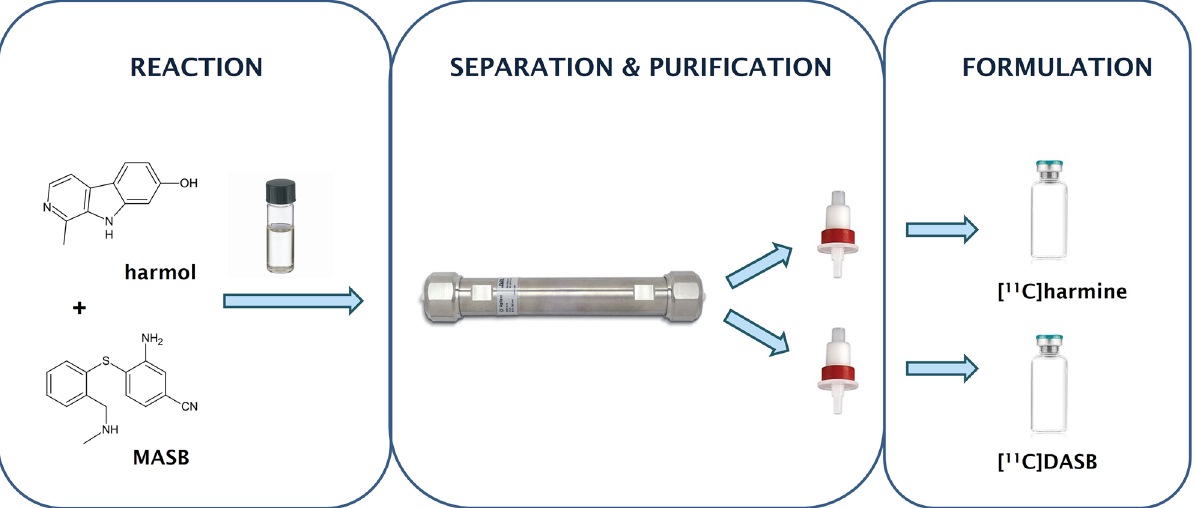
Figure 2. Illustration of the ‘two-in-one-pot’-concept. Two reactions are performed in the same reaction vial, using two different precursors and the same reactant (e.g. [ 11 C]CH 3 I). In the second step, the separation takes place on a semi-preparative HPLC column, the pure products are purified from the mobile phase and further formulated to separate solutions, which can be applied to